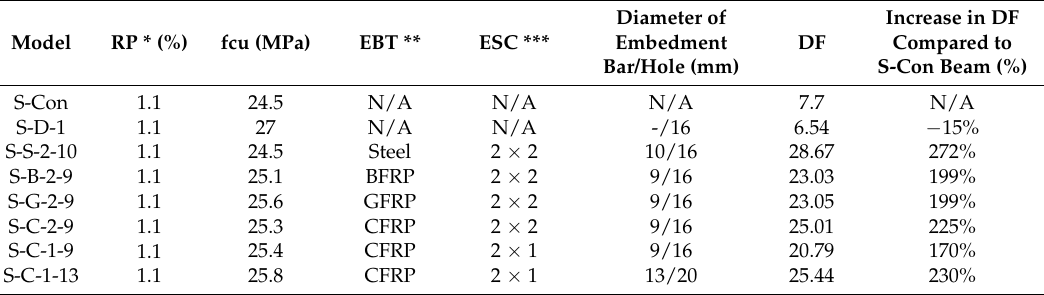
Table 3. Deformability factors of all the test